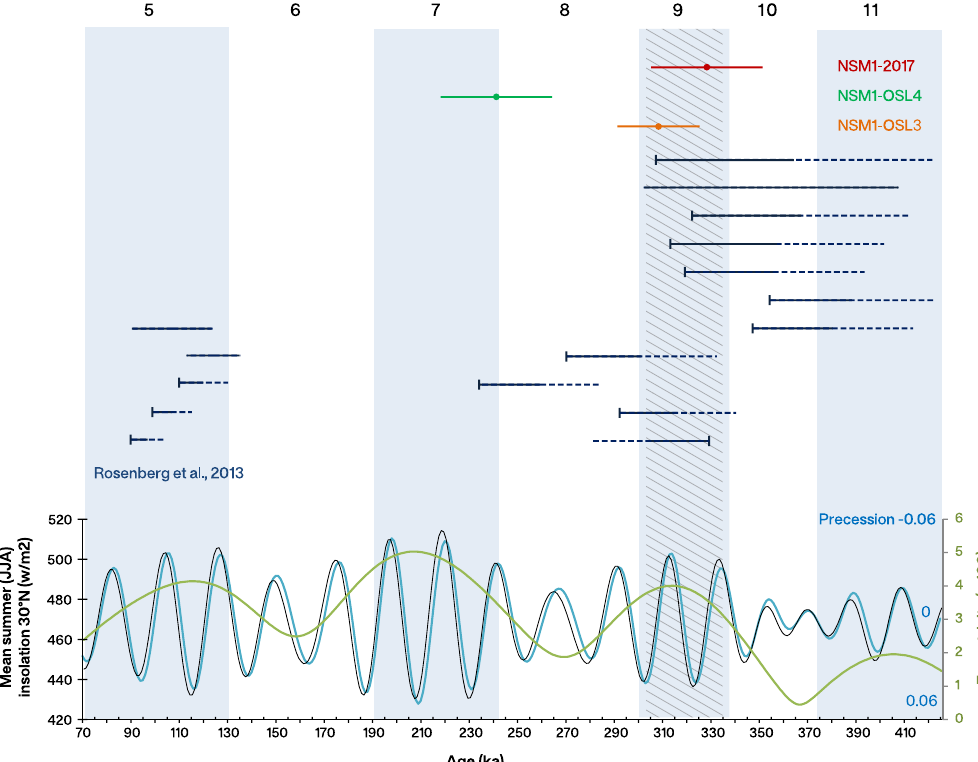
Figure 5. Luminescence ages from the An Nasim site, displayed above the orbital parameters (derived from 44 ) which produced humid episodes in the Arabian Peninsula (eccentricity [green] modulation of precession [turquoise], with a corresponding influence upon summer [JJA] insolation at the latitude of the Nefud [black], driving monsoon incursion). Marine Isotope Stages of the last 700 ka are displayed for reference. Navy blue bar data are from 23 and are displayed as follows. Solid bars indicate lake formation occurred during this range (a direct date or paired bracketing ages). Dashed lines with endcaps and thick bars to the left indicate maximum (underlying, no unconformities) ages for lake formation—which likely occurred either before (i.e. older than) the endcap, or during the period denoted by a thick bar. Dashed lines with endcaps and thick bars to the right indicate minimum (overlying, no unconformities) ages for lake formation—which likely occurred after (i.e. younger than) the endcap, or during the period denoted by a thick bar. The hashed area shows the high concurrence of data suggesting lake formation in MIS 9. Produced using Microsoft